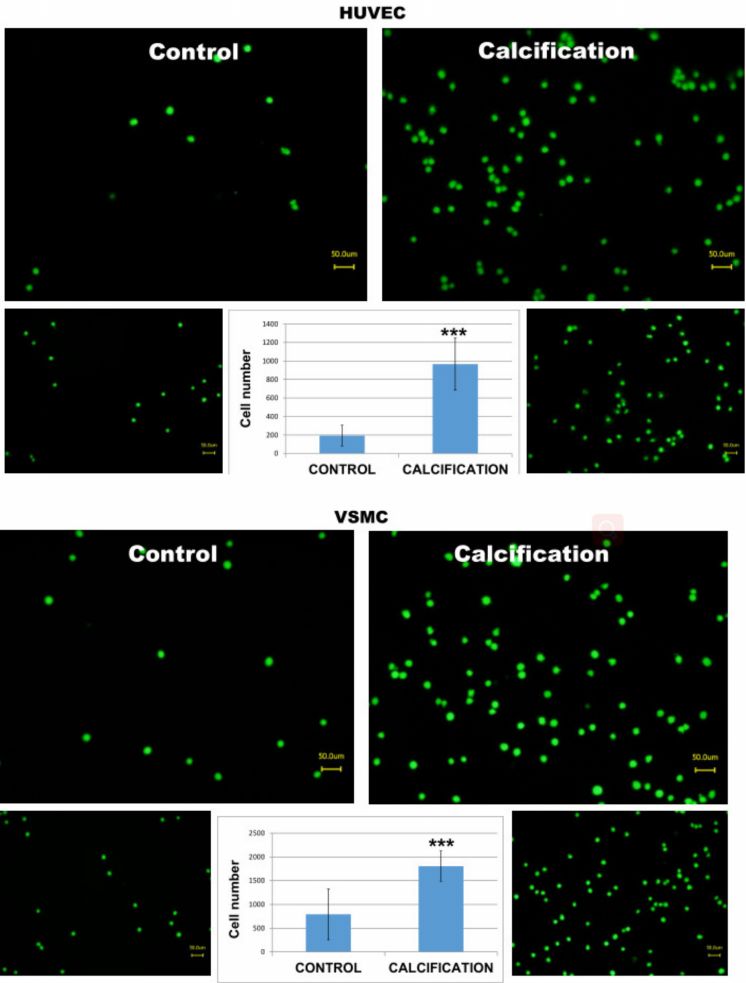
Figure 4. Adhesion of THP-1 monocytes to calcified HUVEC or VSMC cells. Note that a higher number of adhered monocytes is visible in calcified cells as compared to controls. *** means p <